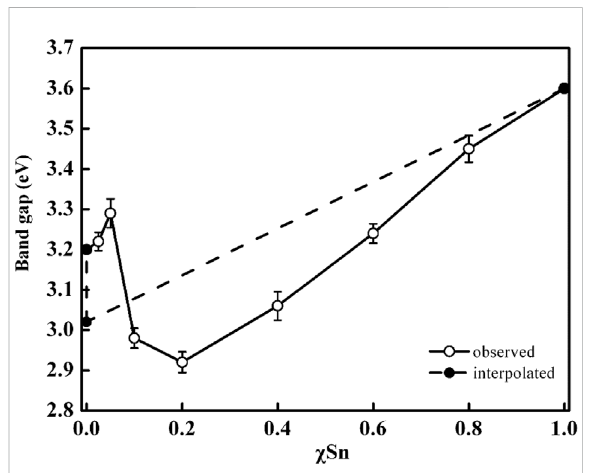
FIGURE 10 Degradation yield of Ti 0.8 Sn 0.2 O 2 mixed solution after seven